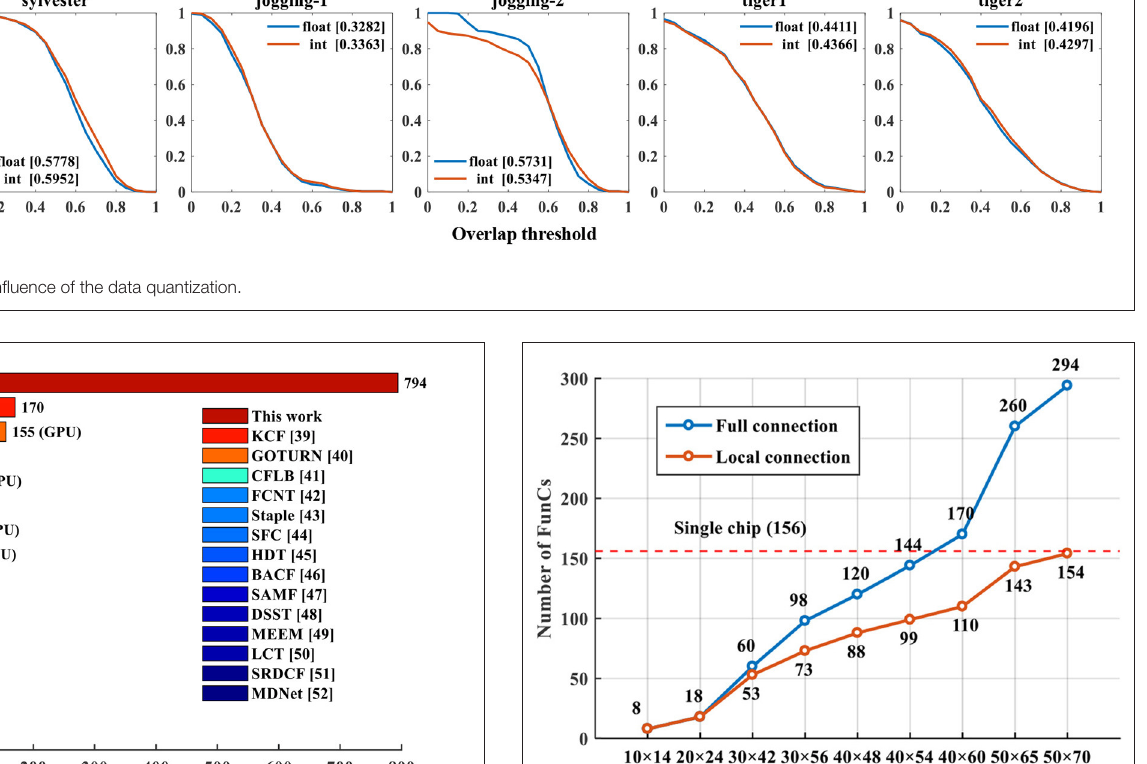
of initialization location can be analyzed (the first frame of each segment can calibrate the initialization). SRE is to sample the initial bounding box in the first frame by shifting or scaling the